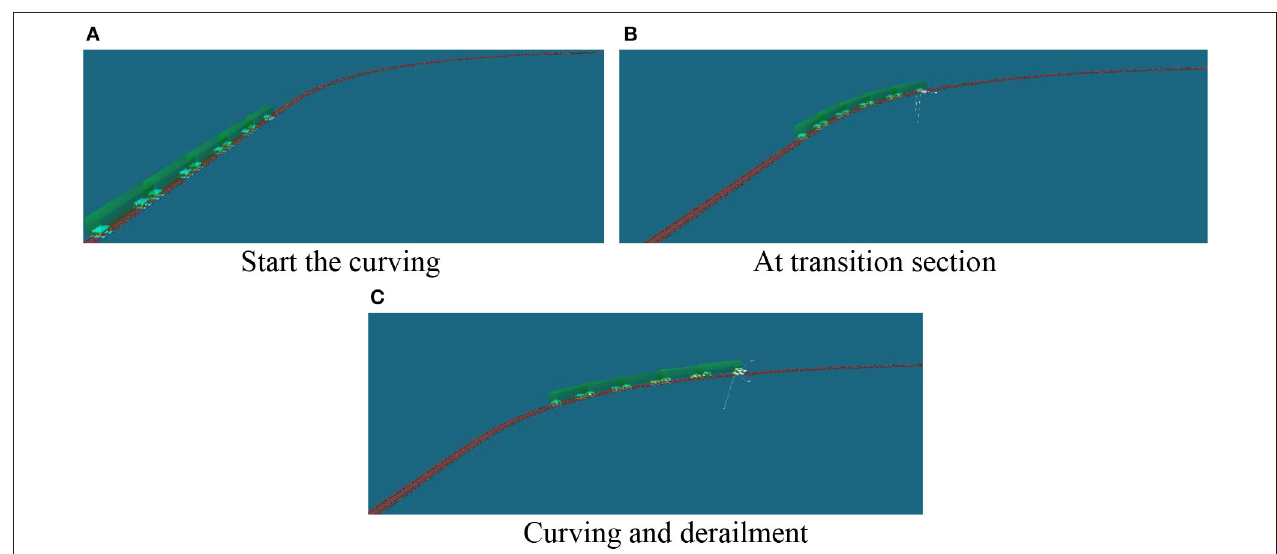
FIGURE 7 | Simulations for first scenario at speed of